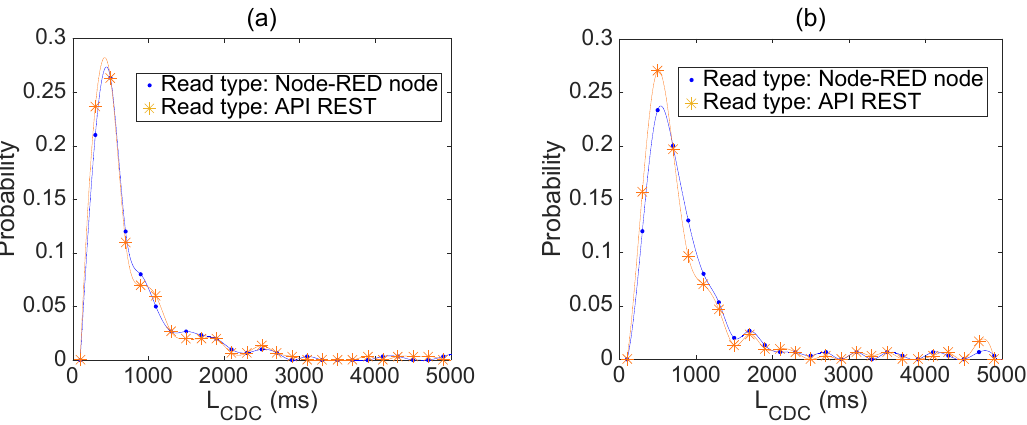
Figure 5. Distribution of the L CDC metric (with L CDC < 5 s) in the four configurations of the software access method; ( a ) write type is Node-RED node and ( b ) write type is REST API.